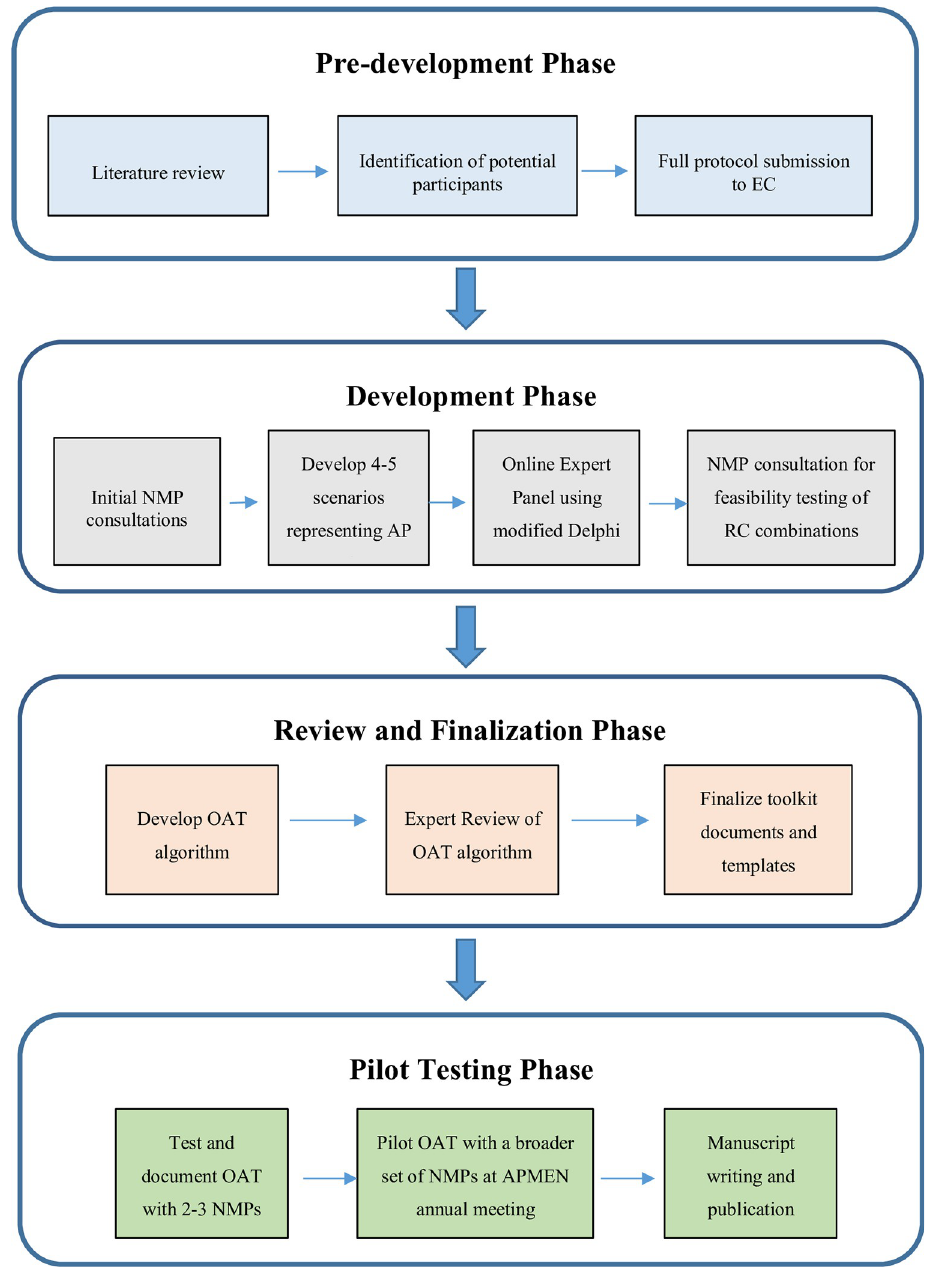
Fig 1. OAT development study